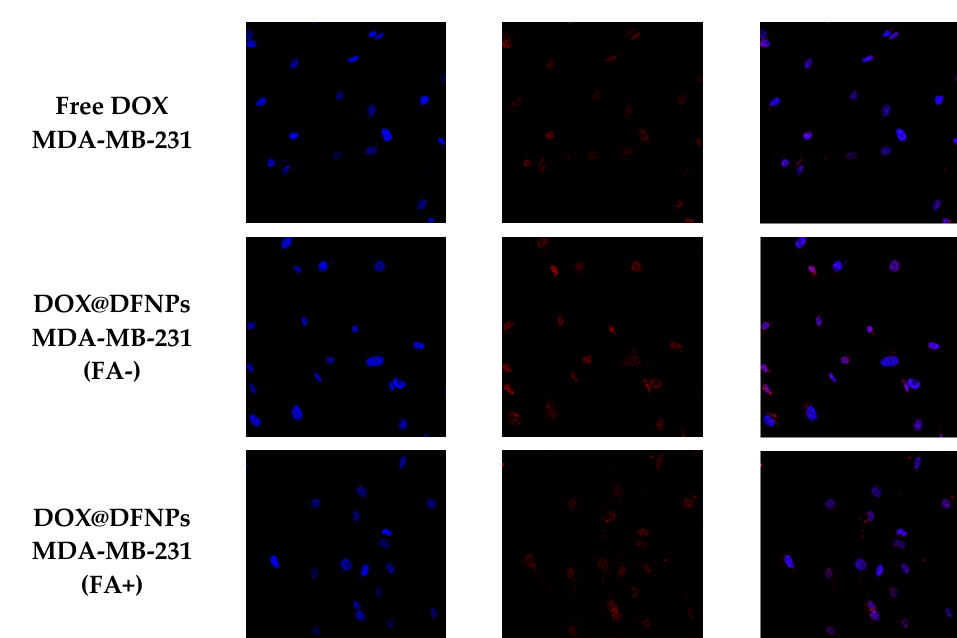
Figure 10. Confocal fluorescence images (40×) showing intracellular DOX or DOX@DFNPs (red fluorescence) and nuclear DAPI (blue signal) in MDA-MB-231 and MCF-10A cells. In (FA+) images, FA receptors were blocked by 1 h pretreatment with free FA, whereas (FA-) images were acquired in the absence of this receptor ligand.